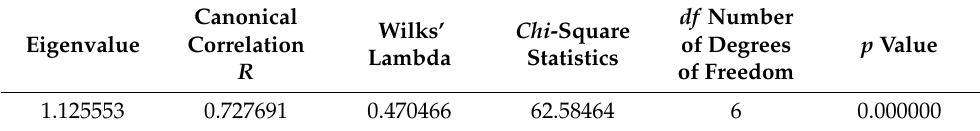
Table 8. Parameters for assessing the statistical significance of the discriminant function.